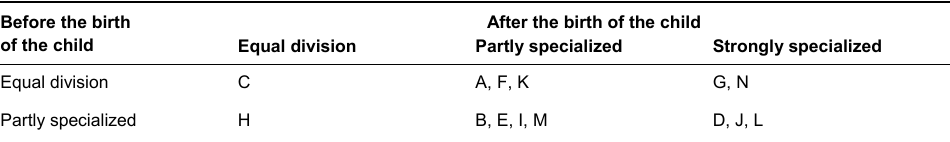
Table 4 : Changes in the division of labor in the transition to parenthood Before the birth After the birth of the child of the child Equal division Partly specialized Strongly specialized Equal division C A, F, K G, N Partly specialized H B, E, I, M D, J,